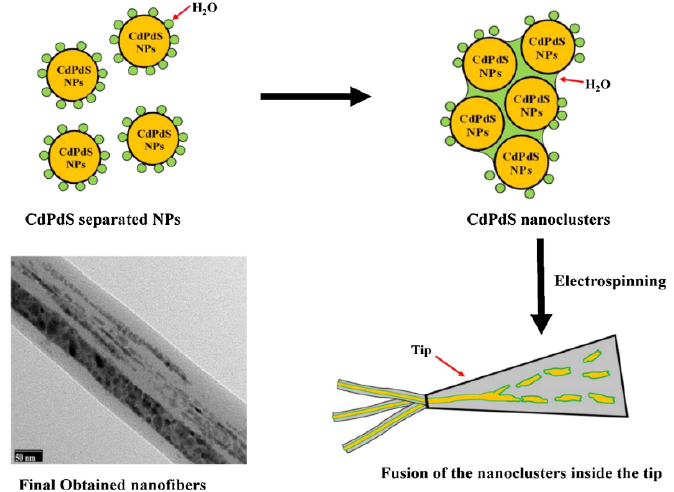
Figure 4. Illustration showing the mechanism of forming the core–shell structure. (Reprinted from the work of Unnithan et al. [27]; Copyright 2012, with permission from Elsevier).